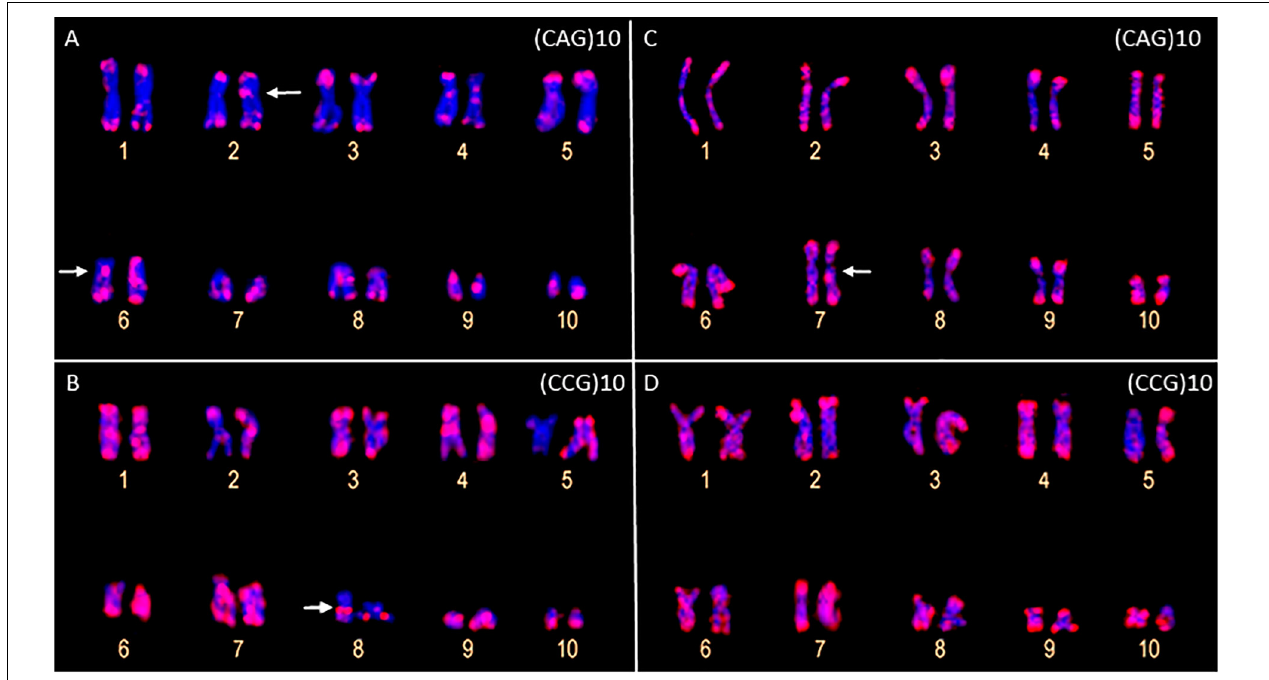
FIGURE 3 | Metaphase chromosomes of Pipa carvalhoi (A,B) and Xenopus tropicalis (C,D) submitted to fluorescent in situ hybridization with probes for the microsatellite repeat motifs (CAG) 10 (A,C) and (CCG) 10 (B,D) . The arrows indicate the minor hybridization signals detected in the non-terminal regions of the chromosomes.